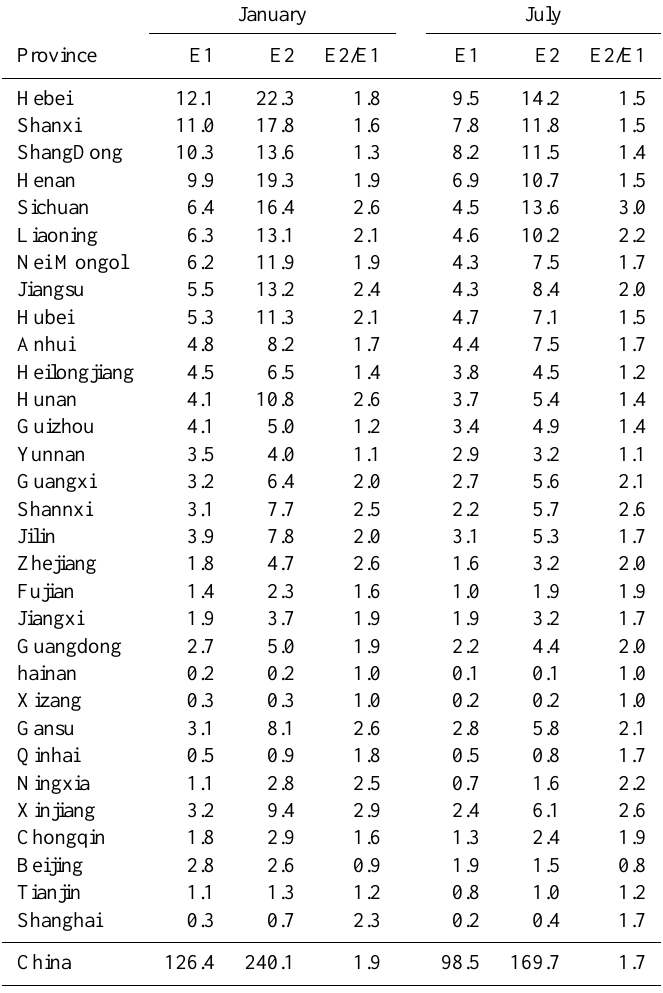
Table 2. Estimates of provincial BC emission (Gg) by bottom-up and inverse method.